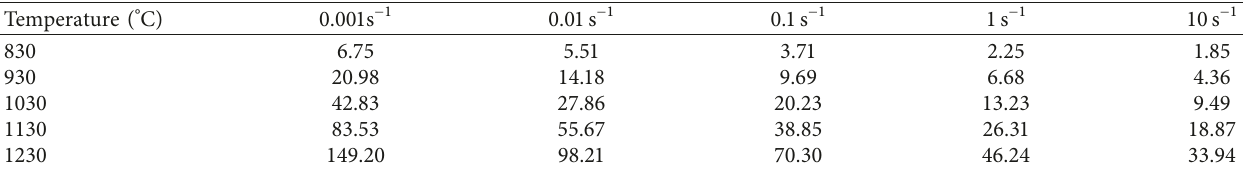
Table 2: Average dynamic recrystallization grain size ( μ